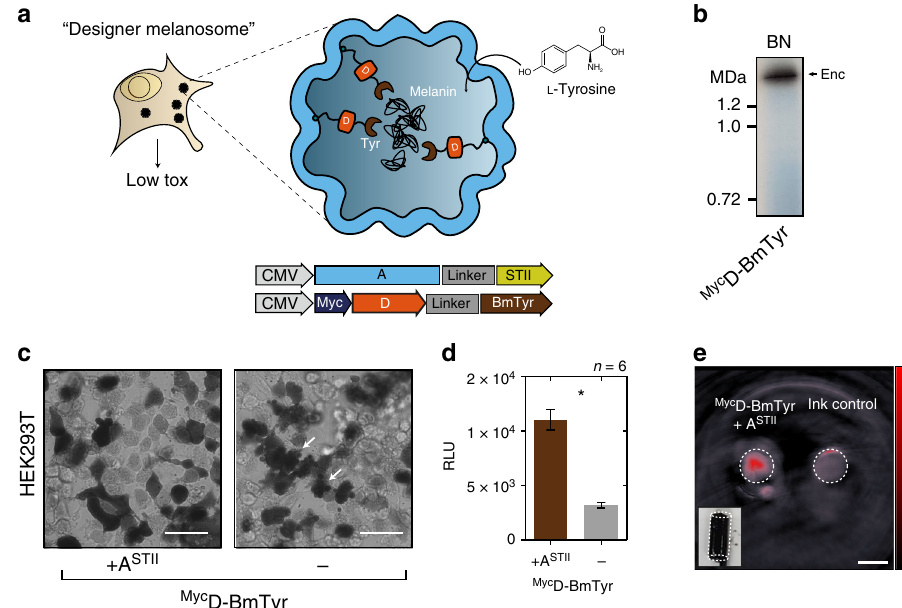
Fig. 5 Bioengineering of a melanosome by targeting melanin-generating tyrosinase to the encapsulin compartment. a Schematic of the detoxifying effects of compartmentalized melanin production by encapsulated tyrosinase from Bacillus megaterium targeted to the nanocompartment via fusion to the native cargo D. The substrate L -tyrosine enters the compartment via the pores in the nanoshell. b BN-PAGE showing on-gel production of melanin via tyrosinase expressed in HEK293T cells fused to Myc-tagged encapsulin-cargo D ( Myc D-BmTyr) to encapsulate it in the assembled nanoshell. Dark colorization of the band was observed after incubation with 2 mM L -tyrosine and 100 µ M CuCl 2 in PBS (pH 7.4) for 1 h at 37 °C. c Bright- fi eld images of HEK293T cells expressing Myc D-BmTyr with and without StrepTagII-modi fi ed shell (A STII ) after 48 h of expression. Twenty four hours post transfection, cells were supplemented with 1 mM L -tyrosine and 10 µ M CuCl 2 . Cell protrusions (white arrows) were apparent indicating toxic effects of overexpression of non- encapsulated tyrosinase. Scale bar: 20 µ m. d Corresponding luciferase-based viability assay of HEK293T cells treated as in c overexpressing Myc D-BmTyr with or without A STII after 48 h. (The bars represent the mean ± SEM, n = 6, p < 0.0001, unpaired t -test.) e Images of two tubular phantoms (transversal slice) obtained by multispectral optoacoustic tomography (MSOT). The phantoms were fi lled with ~10 7 cells in 1.5% low melting agar expressing Myc D- BmTyr with A STII (supplementation as in c and d ) or containing highly concentrated ink (OD = 0.2) as control showing the intense contrast obtained between 690 nm and 900 nm from the melanin-producing encapsulins. The coef fi cients obtained from linear unmixing of the optoacoustic spectra with a melanin reference spectrum are displayed on the red colormap overlaid on the image obtained at 720 nm. The lower left inset shows a color photograph of the tubular phantom containing the cells. Scale bar: 3